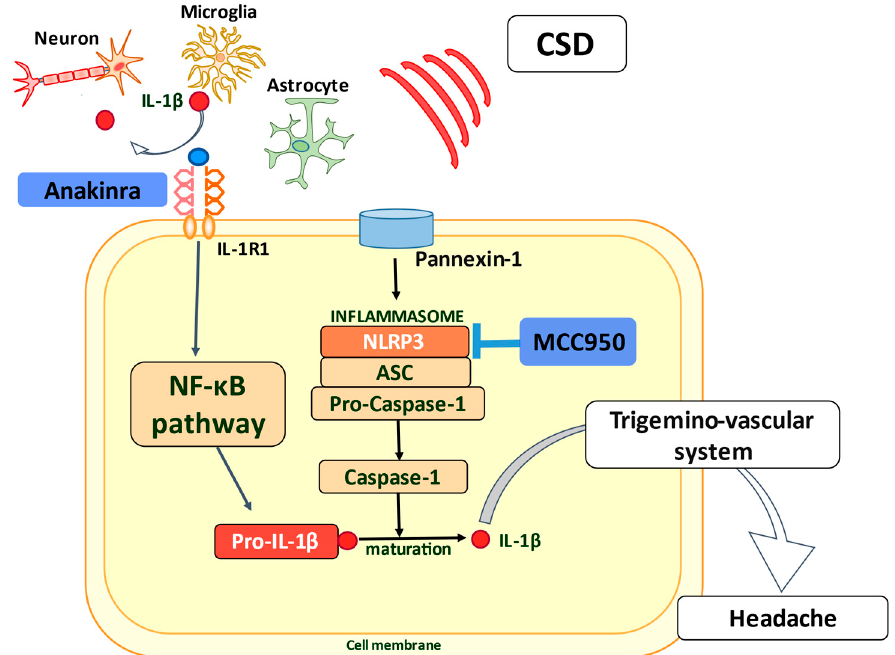
Figure 2. Potential for therapies using the IL-1 β /IL-1R1 axis.